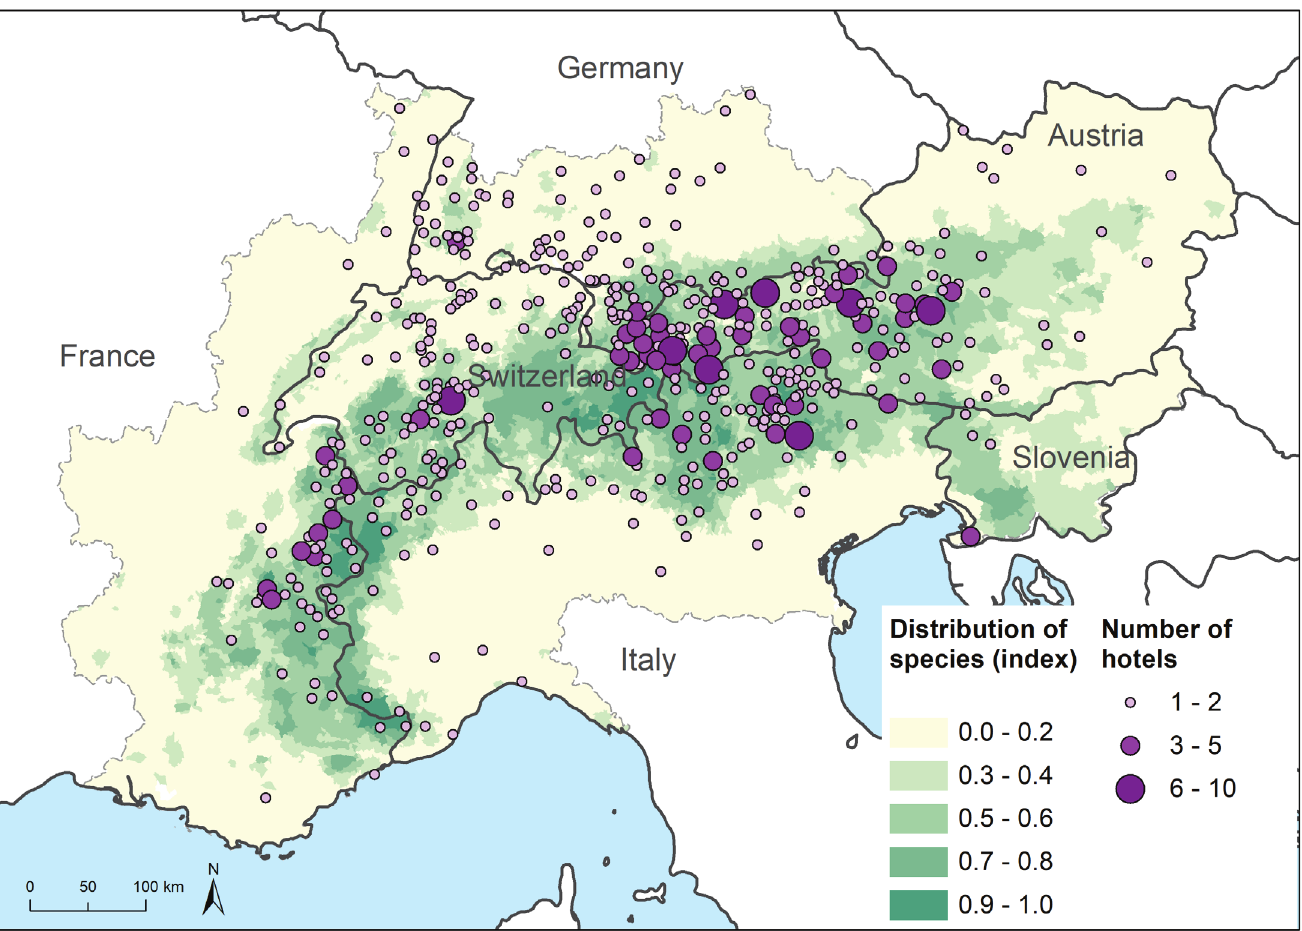
Figure 3. Spatial distribution of habitats of symbolic species and hotels that refer to symbolic species in their names in the Alpine Space area. Data sources: Rüdisser et al. (2019) and Schirpke et al.